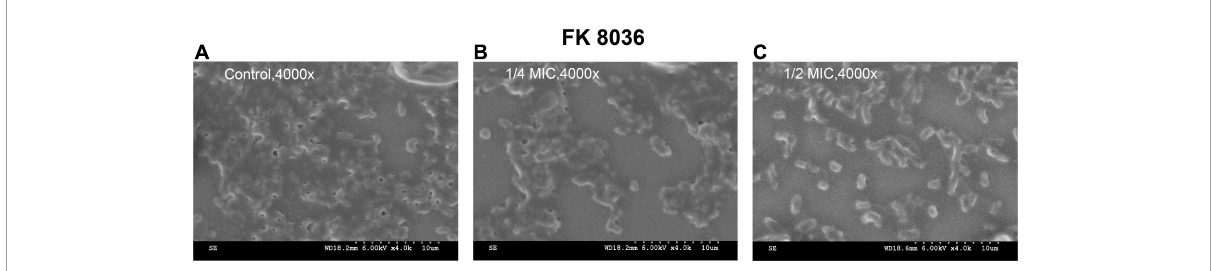
FIGURE9 Scanning electron microscopy (SEM) images of the effects of chlorogenic acid (CA) treatment on the bacterial number and biofilm formation of FK 8036. (A) LB broth control group, 4,000 × ; (B) 1/4 minimum inhibitory concentration (MIC) CA monotherapy, 4,000 × ; (C) 1/2 MIC CA monotherapy, 4,000 × .